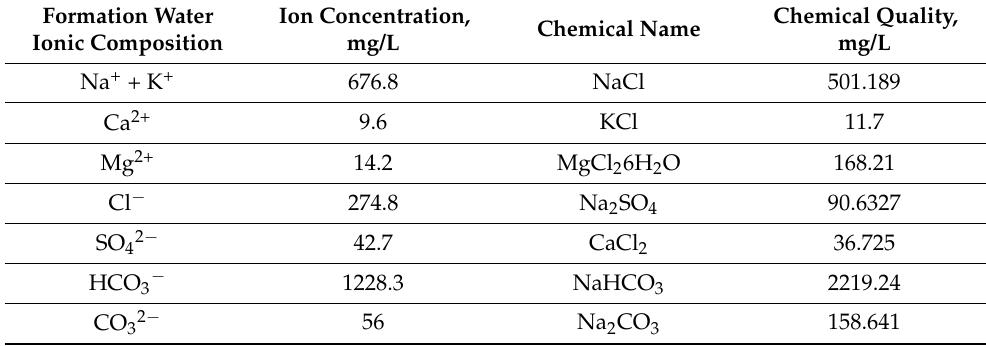
Table 1. Water quality analysis and chemicals required for the preparation of simulated water.